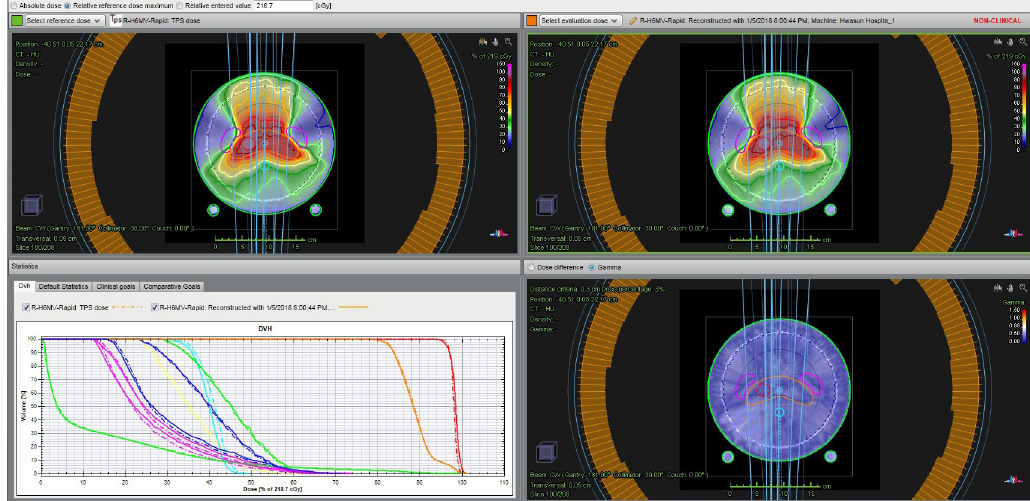
Fig 4. Example of the dose reconstruction based on the dose data measured using